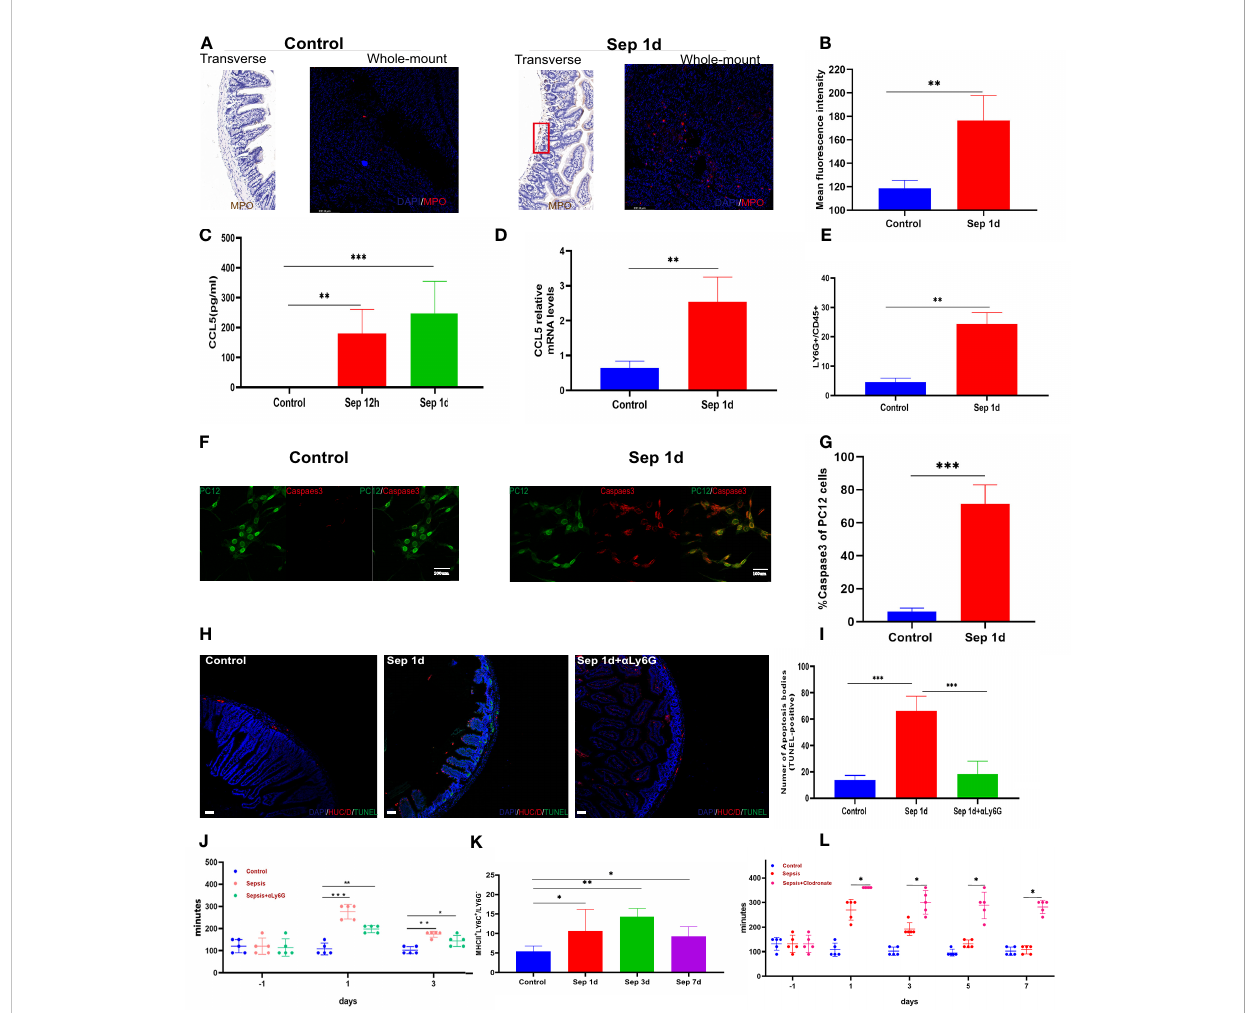
FIGURE 2 Up-regulates the expression of neutrophils. (A, B) Control and sepsis on day 1 of intestine transverse and intestine whole mount myeloperoxidase immunohistochemistry, immuno fl uorescence staining, and statistical histogram of myeloperoxidase fl uorescence intensity changes. (C) Changes of plasma CCL5 levels 12 and 24 h after KP sepsis. (D) Changes in CCL5 mRNA levels in the intestinal muscularis (E) : LY6G + neutrophils in the intestinal muscularis 24 h after KP sepsis. (F, G) Immuno fl uorescence staining of PC12-GFP transgenic cells after co-culture with bone marrow neutrophils and percentages of Caspase3-positive cells. (H, I) Control, sepsis 1 day, and neutrophil depletion sepsis 1 day of intestine transverse HUC/D and terminal deoxynucleotidyl transferase dUTP nick end labeling (TUNEL) double fl uorescent staining and statistical histogram of neuronal apoptosis. (J) The carmine red experiment detects changes in intestinal transit time between the control, KP sepsis, and neutrophil depletion sepsis groups. (K) The histogram of statistical changes in MHCII hi expressing cell populations shows the changes in M Μ f s detected by fl ow cytometry experiments. (L) The carmine red experiment detects changes in intestinal transit time between the control group and KP sepsis and macrophage depletion sepsis groups. Differences between groups were signi fi cant at a P value of <0.05. * Represents p <0.05, ** represents p <0.01, and *** represents